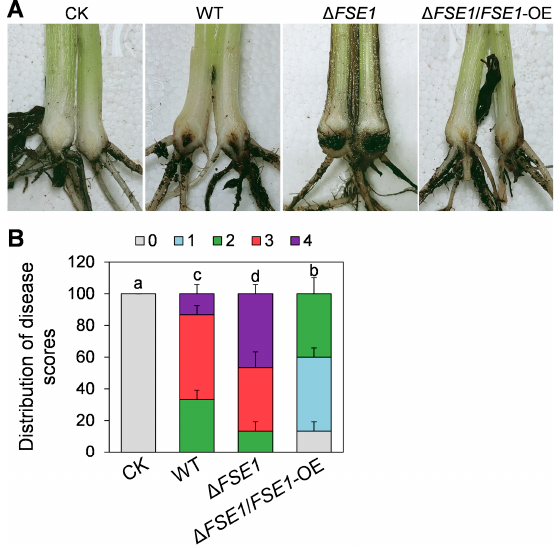
Figure 3. Pathogenicity assays of the FSE1 knockout and overexpression mutants. Banana plantlets were inoculated with conidia suspension of Foc TR4 strains; after incubation for 5 weeks, the banana pseudostem were sampled and used for the disease symptoms and disease scores investigation. ( A ) Disease symptoms of rhizome and pseudostem of banana plantlets after infection for 5 weeks. ( B ) Distribution of disease scores. Treatments with different letters indicate significant difference ( p < 0.05). CK, banana plantlets treated with ddH 2 O.